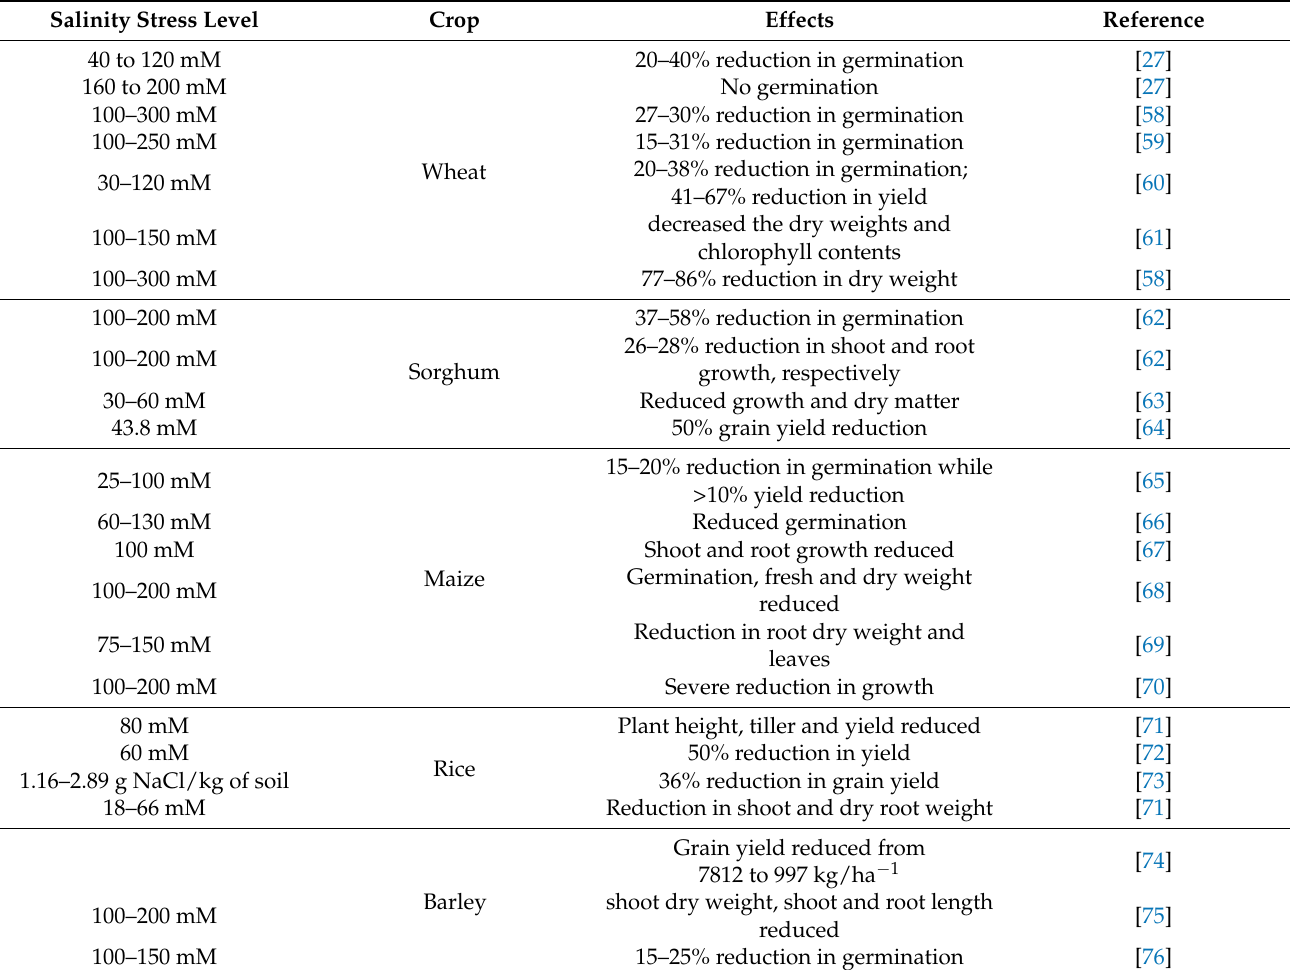
Table 1. Morphological effects on cereal crops under salt